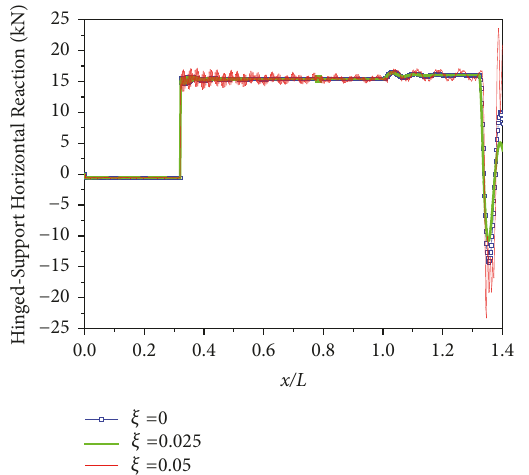
Figure 19: Longitudinal reaction at hinged support of simply supported beam with different